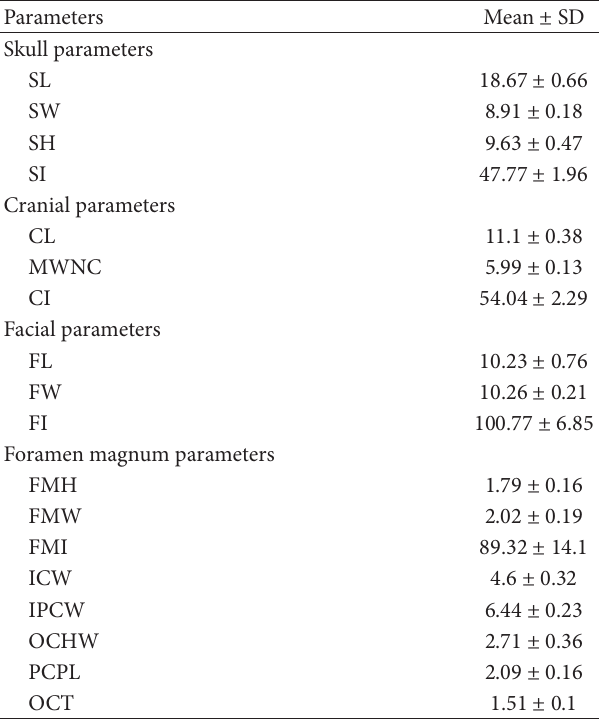
Table 1: The various osteometrical measurements of the skull of the Markhoz